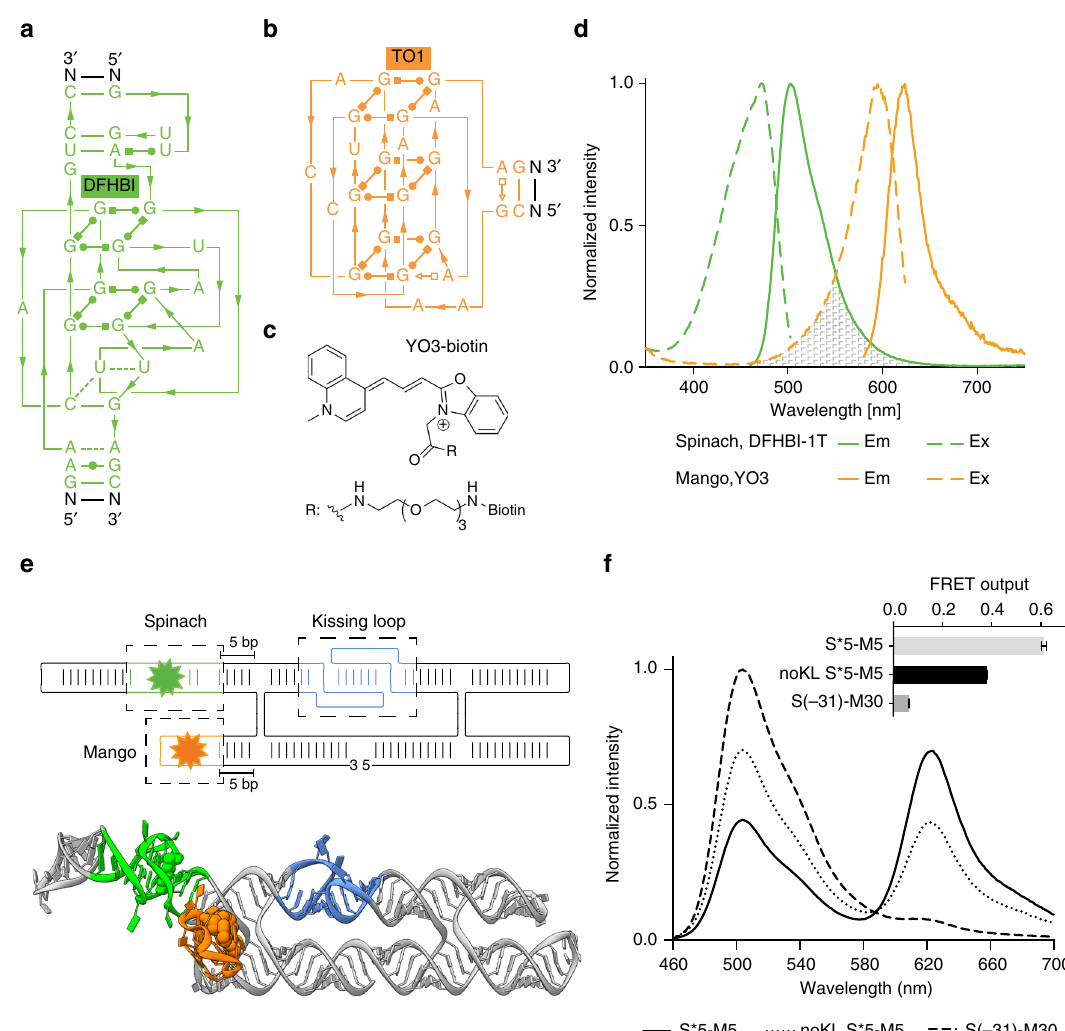
Fig. 1 FRET between fl uorescent aptamers on RNA origami scaffolds. a Structure diagram of the minimal core of the Spinach aptamer 31, 32 (green). The binding site of DFHBI-1T is indicated. Lines with arrows denote chain connectivity and Leontis-Westhof symbols 52 denote noncanonical base pairs. b Structure diagram of the minimal core of the Mango aptamer 26 (orange). The binding site of TO1-biotin is indicated 26 . c Chemical structure of YO3-biotin. d Excitation and emission spectra of DFHBI-1T and YO3-biotin in the Spinach and Mango construct, respectively. Spectral overlap between the emission spectrum of DFHBI-1T and the excitation spectrum of YO3-biotin is marked in gray. e 2D diagram and 3D model of an aptamer-based FRET (apta-FRET) construct showing the kissing-loop (blue), Spinach (green), and Mango (orange). The stem length between the construct crossover and both Spinach (S) and Mango (M) is 5 bps (and is thus named “ S*5-M5 ” , see text and Fig. 2 for further descriptions of nomenclature). The 3D model is shown in cartoon representation with fl uorophores shown in space- fi ll representation. f Fluorescence spectra of apta-FRET constructs after excitation of DFHBI-1T. The solid line is the S*5-M5 construct, the dotted line is the S*5-M5 construct designed without a kissing-loop (KL), and the dashed line is the S(-31)-M30 construct designed to have no FRET. The inset shows calculated FRET outputs of the three constructs. Error bars indicate standard deviations